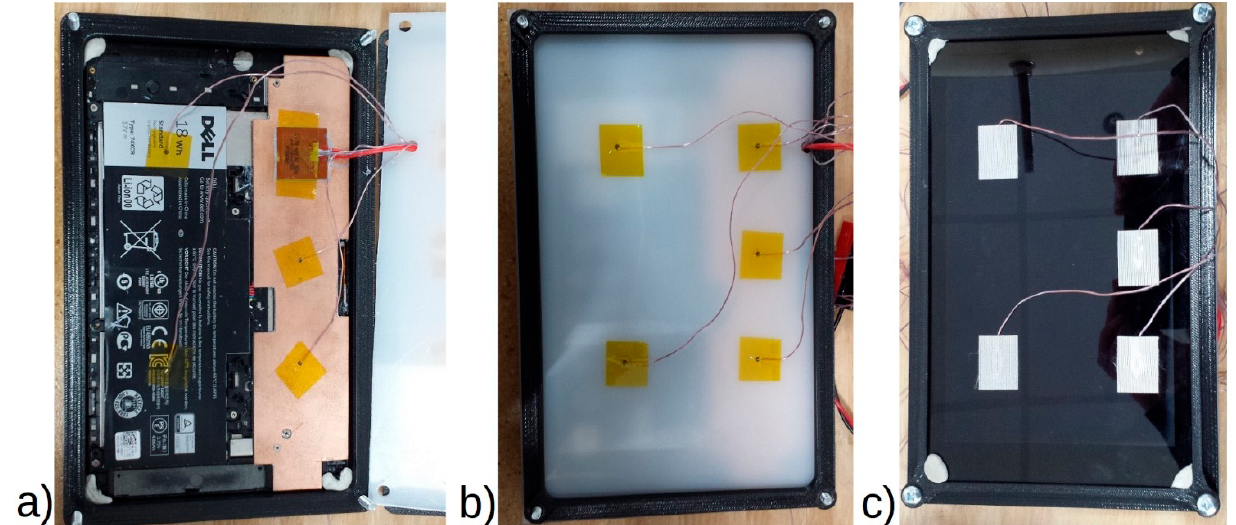
Figure 1. Rendering showing an exploded view of the mock tablet.